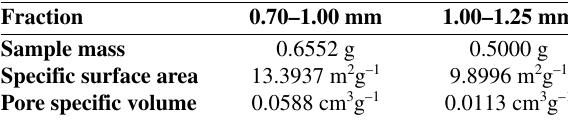
Table 2. Results of Sorptomatic measurements.